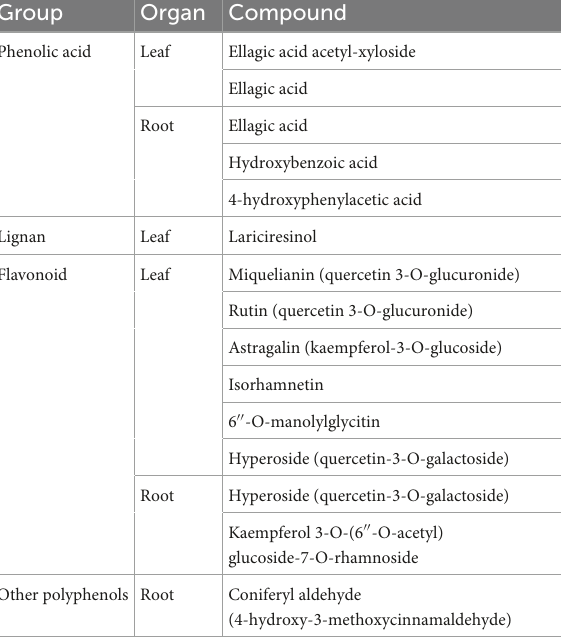
TABLE 2 Significant changes in leaves and roots of 6-month-old Castanea sativa seedlings subjected to 7 days of heat stress ( n = 18; heat phase) and 10 days after application ( n = 12; recovery phase).